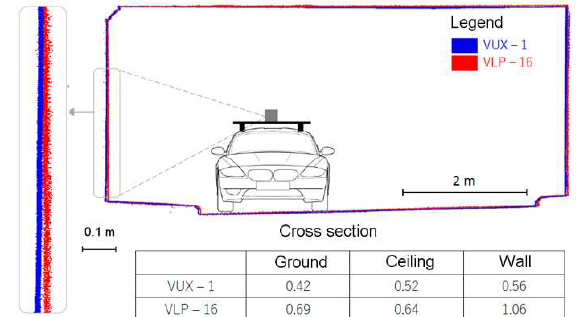
Figure 17: Difference between VUX1 and PUCK point cloud on a tunnel section. The histogram on fig. 16 the distribution of differences according to surface normal while the table at bottom shows the surface noise for each scanner.